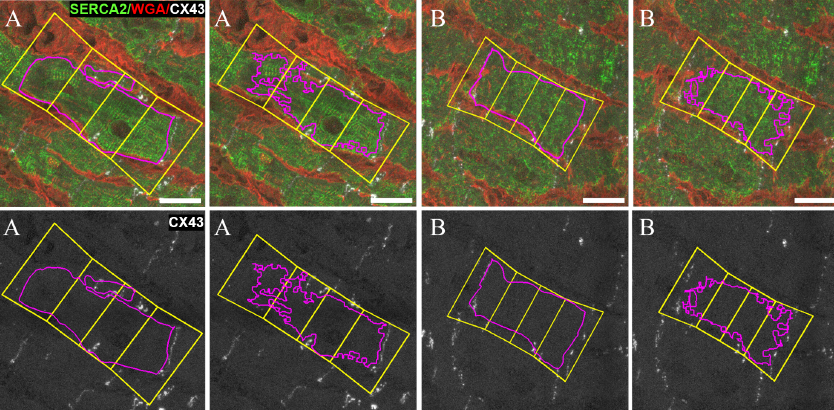
Figure 11. Representative images of box partitioning for two CMs A and B of the manual M m ( left ) and automatic M a ( right ) masks. Top: overlay of channels c 1 (SERCA2, green), c 2 (CX43, white) and c 3 (WGA, red) and results of CMs contour in pink, and the minimum area rectangles enclosing them in yellow. Rectangles are divided into four regions corresponding to polar (i.e., end-to-end) and lateral (i.e., middle) cell compartments. Bottom: channel c 2 without binarization. Polar CX43 bands appear as discontinuous line patterns because of the low signal intensity. Scale bar = 20 µ